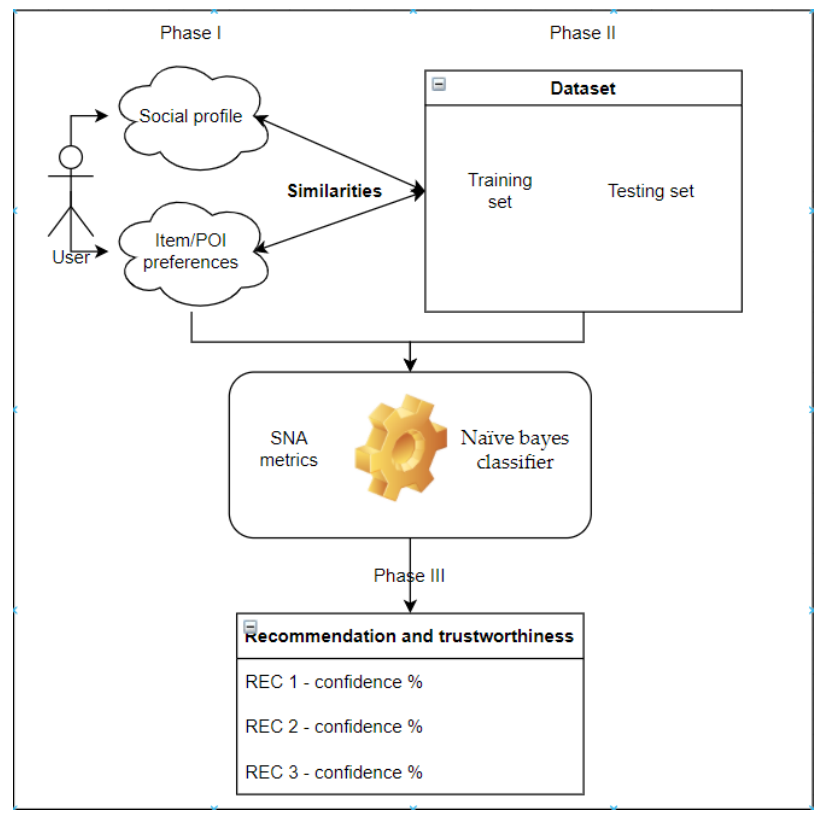
Figure 1. Our Recommender System overview, with inclusion of SNA and trustworthiness metrics on evaluation process.